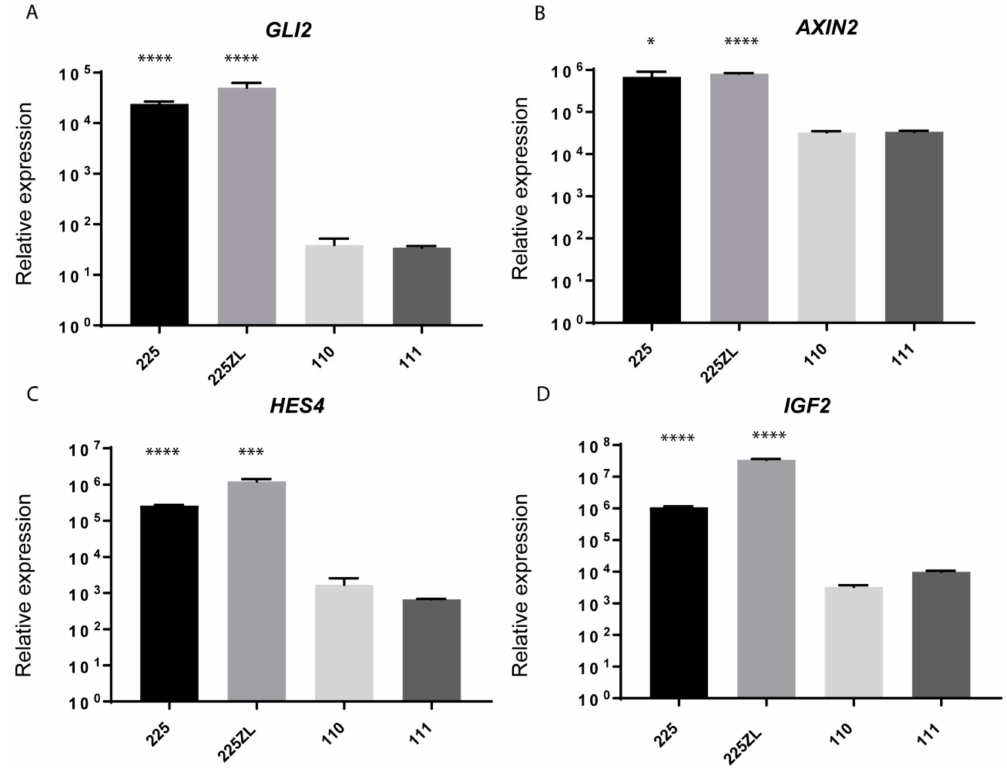
Figure 3. Embryonal pathways are activated in the tumor relapse. GLI family zinc finger 2 ( GLI2 ) ( A ), AXIN2 ( B ), hes family bHLH transcription factor 4 ( HES4 ) ( C ) and insulin-like growth factor 2 ( IGF2 ) ( D ) expression was analyzed by qRT-PCR in the relapse (no 225), the primary tumor cells isolated from the relapse (no 225ZL), and two normal brain regions (no 110, 111). After normalization to the housekeeping gene hypoxanthine phosphoribosyltransferase 1 ( HPRT1 ), the relative quantification